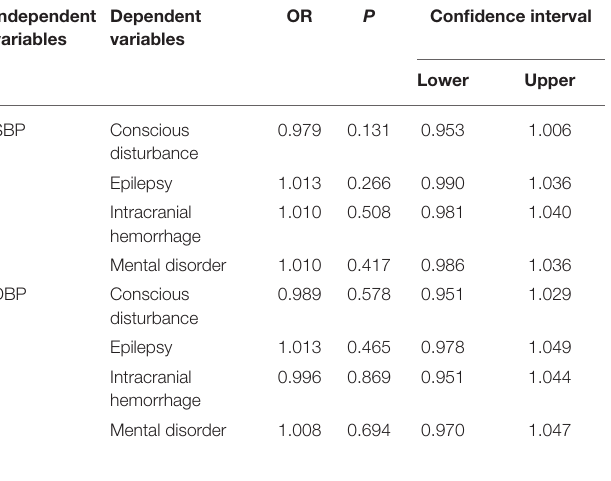
TABLE 2 | Both SBP and DBP had no impact on disturbance of consciousness, epilepsy, intracranial hemorrhage and mental disorders. Independent variables